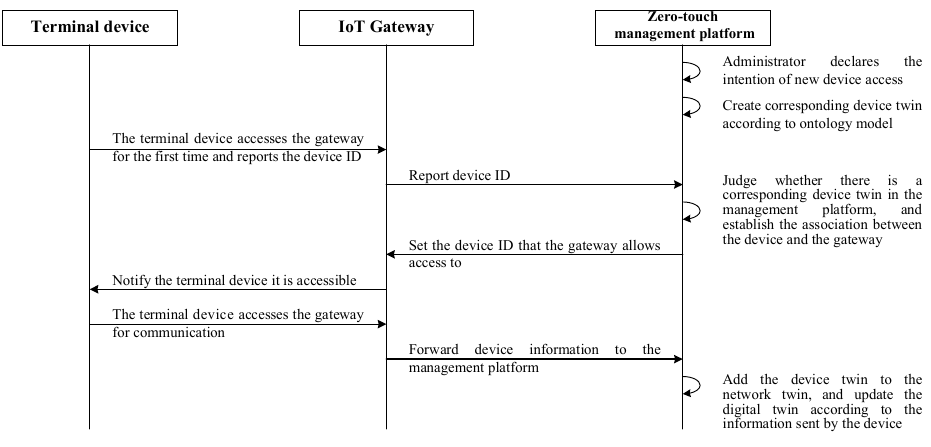
Figure 8. The device access process.